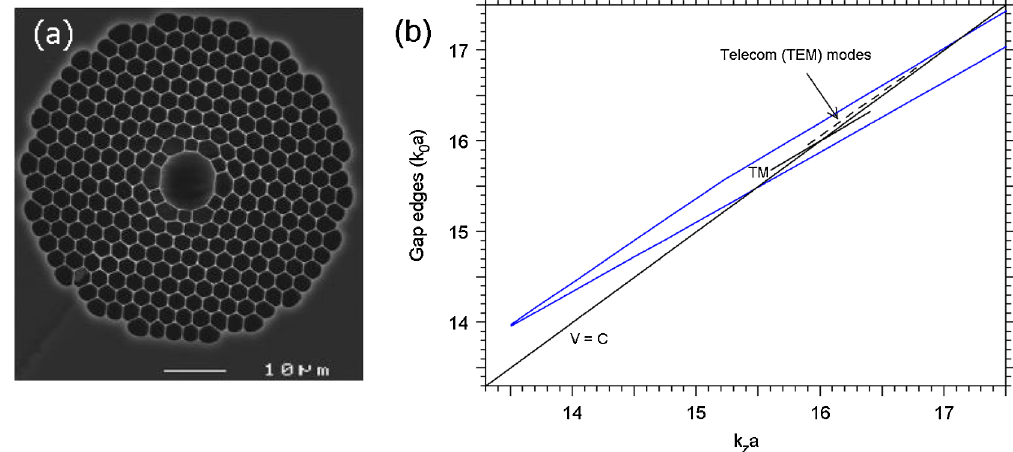
FIG. 18. (a) Cross section of commercial HC-1060 telecom fiber (NKT Photonics [29]) and (b) band gap diagram showing location of telecom modes (dashed line) and TM defect mode (solid line) relative to the light line ( v ¼ c ) as calculated with R-Soft BANDSOLVE